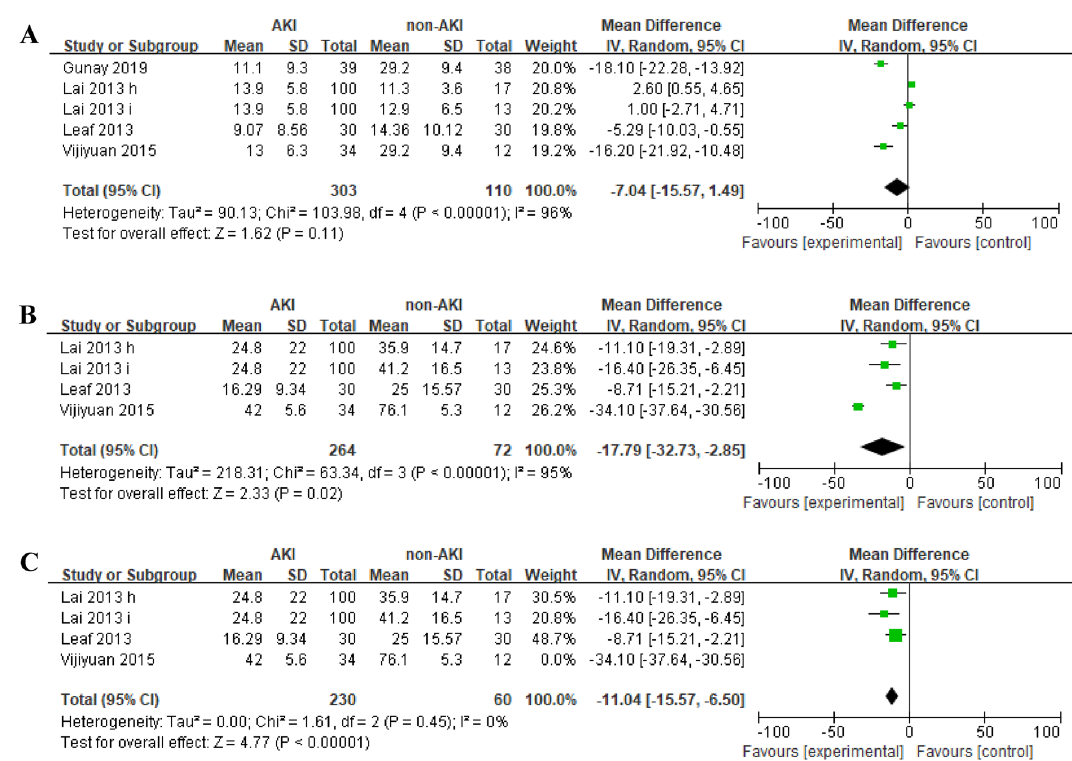
Figure 2. Forest plots of the effect size of the association between the incidence of AKI and serum ( A ) 25(OH) D levels ( B )